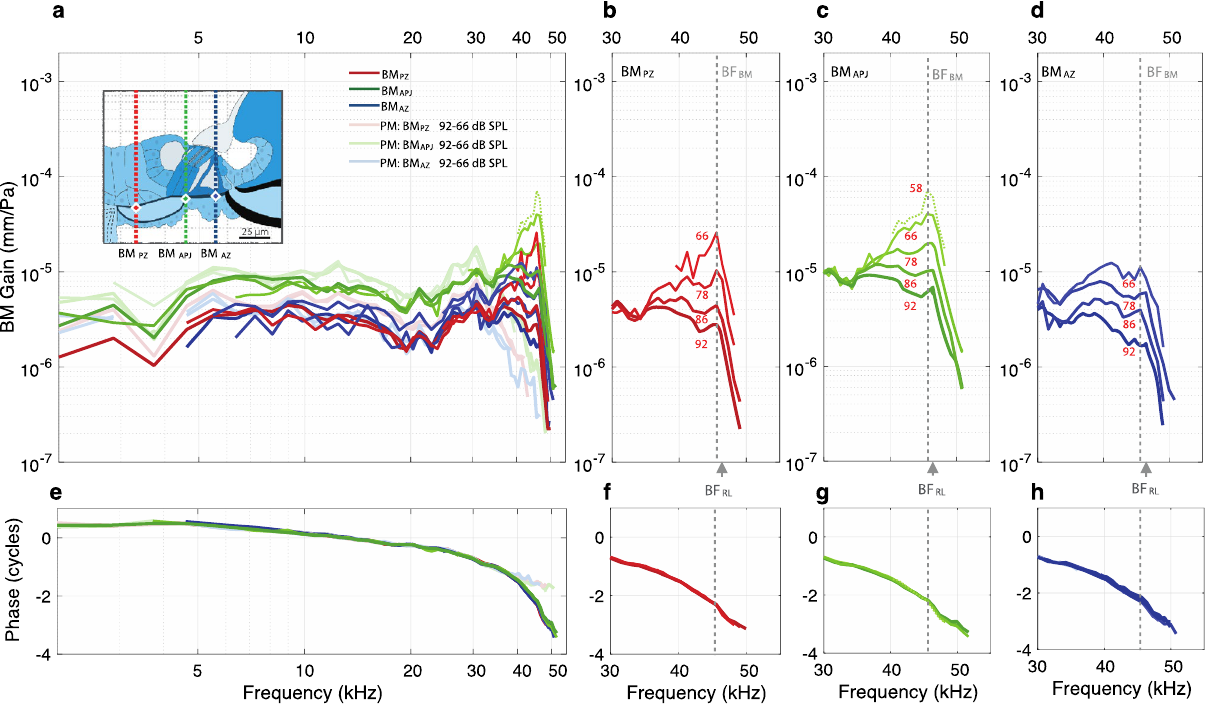
Figure 8. In vivo and PM motions across three BM locations (BM PZ , BM APJ , and BM AZ ), for specimen G637. ( a ) In vivo (darker colors) and PM (faded colors) BM PZ , BM APJ , and BM AZ gains with respect to the stimulus pressure (in units of mm/Pa). The inset drawing shows the measurement locations for BM PZ (red diamond) BM APJ (green diamond), and BM AZ (blue diamond). Each colored vertical line indicates the lateral position and direction of the OCT A-scans. ( b–d ) The respective in vivo gains of the BM locations, showing active nonlinear amplification in the near-BF region. ( e–h ) The phase responses corresponding to panels ( a–d ). The green dotted line indicates the lowest-level BM APJ measurement. All displacements are normalized by the sound pressure. The frequency axes in the first column are on a log scale, and those of the other columns are on a linear scale.